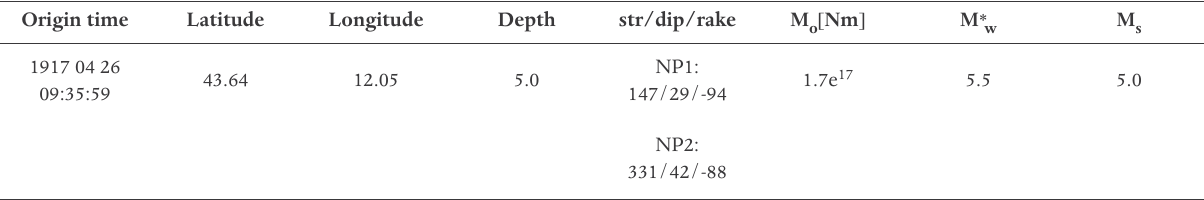
Table 3. Instrumental epicenter location computed with NonLinLoc [Lomax 2005] and main MT solution parameters for the 1917 earth- quake. M following Kanamori w